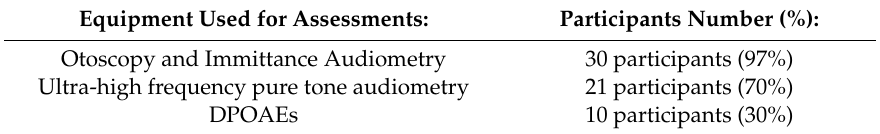
Table 1. Equipment used to perform audiological assessment for patients at risk for ototoxicity. Equipment Used for